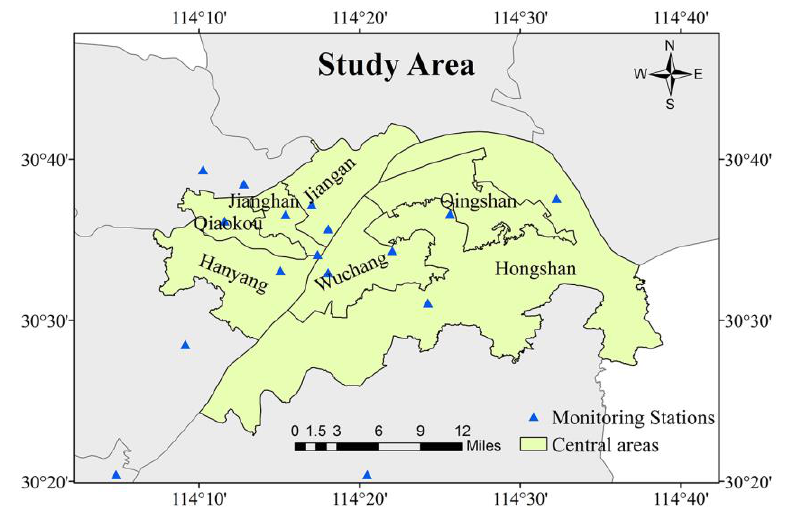
Figure 1. Study region and the distribution of ground monitoring stations.